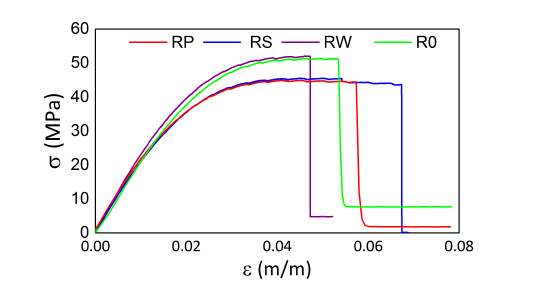
Figure 18. Tensile test results for M3 Crystal samples after exposition on elevated temperatures.